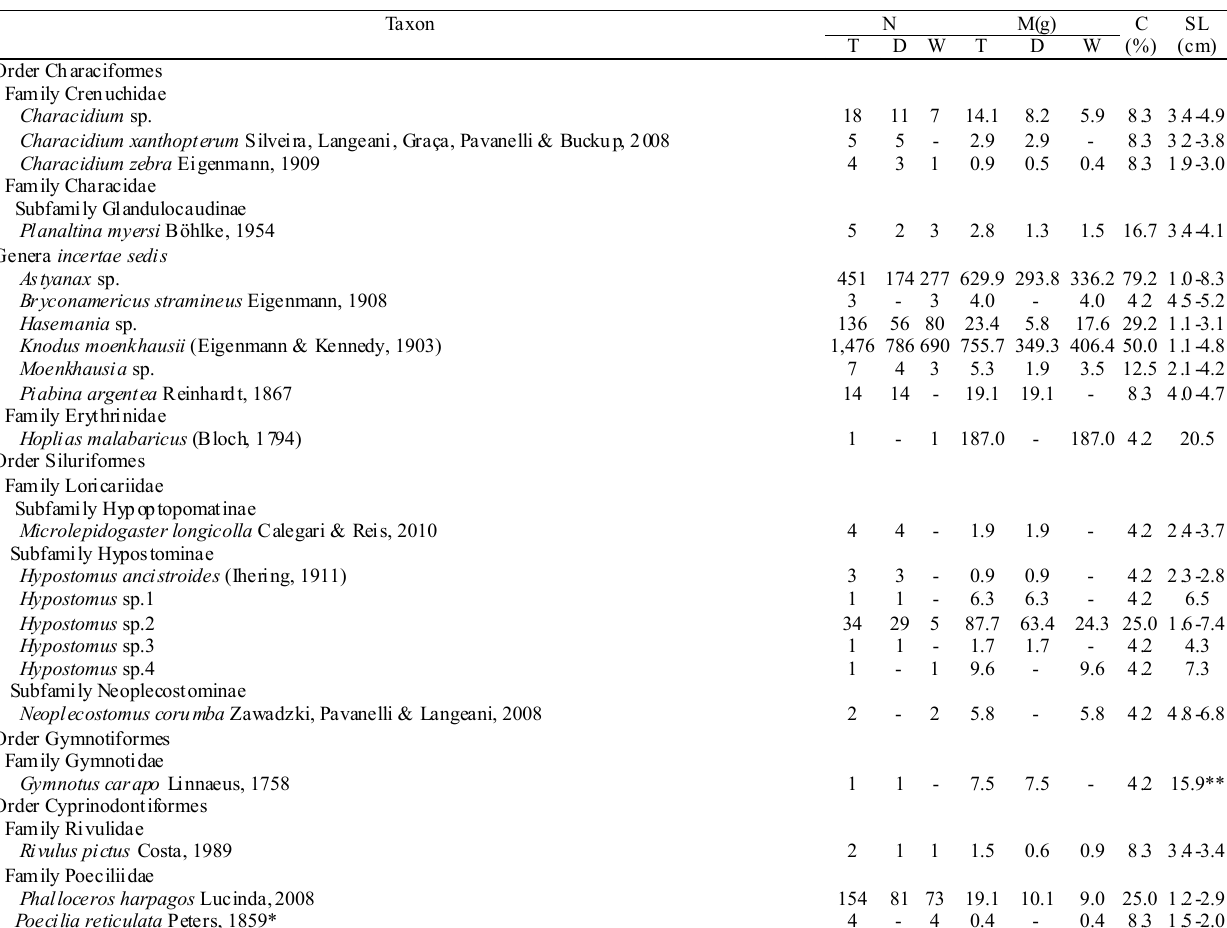
Table 2. Fish species sampled in the APA Gama and Cabeça de Veado with their number of individuals (N) and mass (M) of each species in total (T), dry (D), and wet (W) seasons, occurrence constancy (C), and standard length (SL) range. *Exotic species, **total length. Family group names follow Reis et al .,